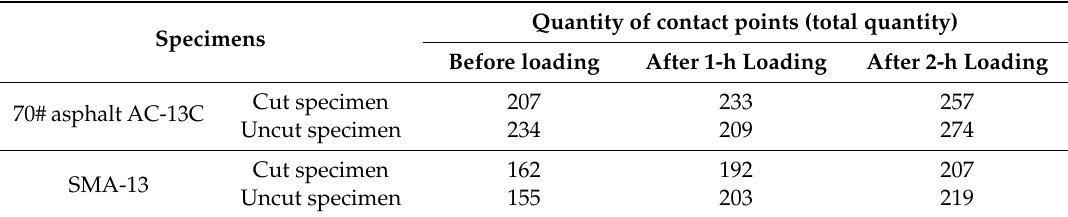
Table 7. E ff ect of specimen cutting on quantity of contact points.